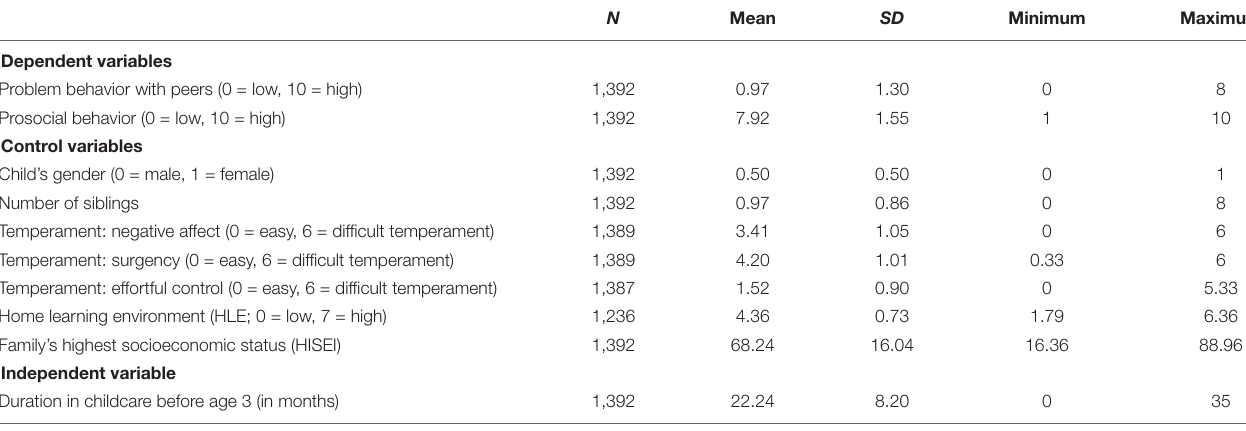
TABLE 2 | Descriptive data on variables in the analyses (children without a migration background).